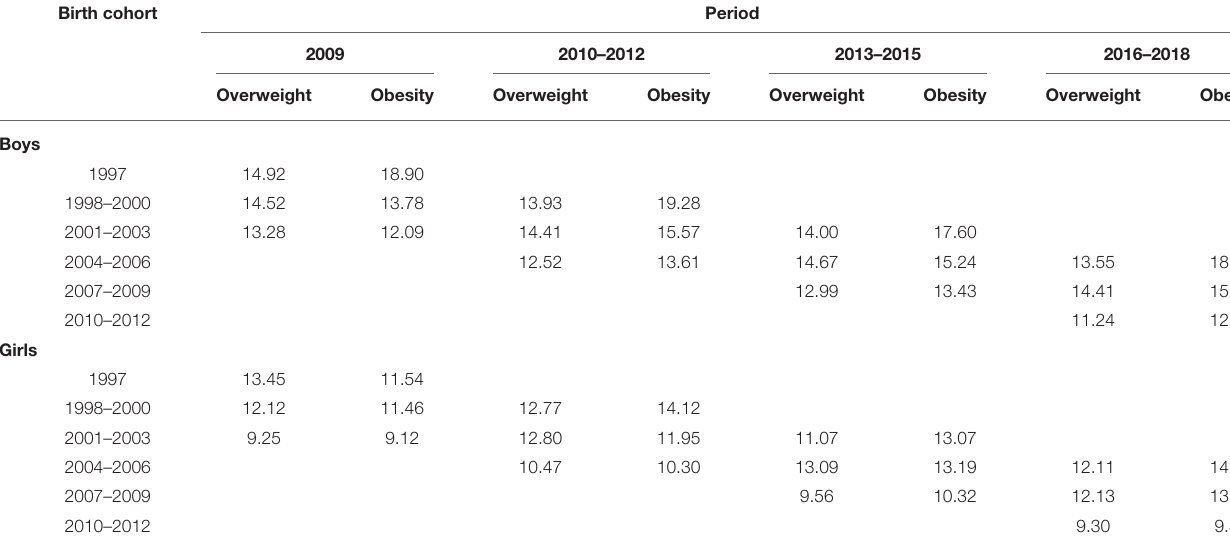
TABLE 3 | Prevalence (%) of overweight and obesity by period and birth cohort, 2009–2018. Birth cohort Period